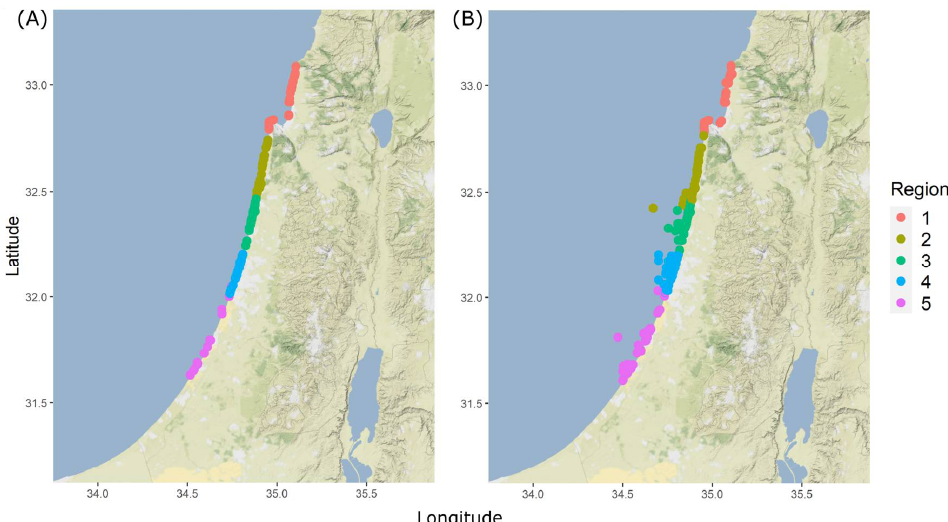
Figure 1. Sampling maps. ( A ) Coastal survey sampling map and ( B ) recreational fishing-at-sea locations reported by the phone surveys.